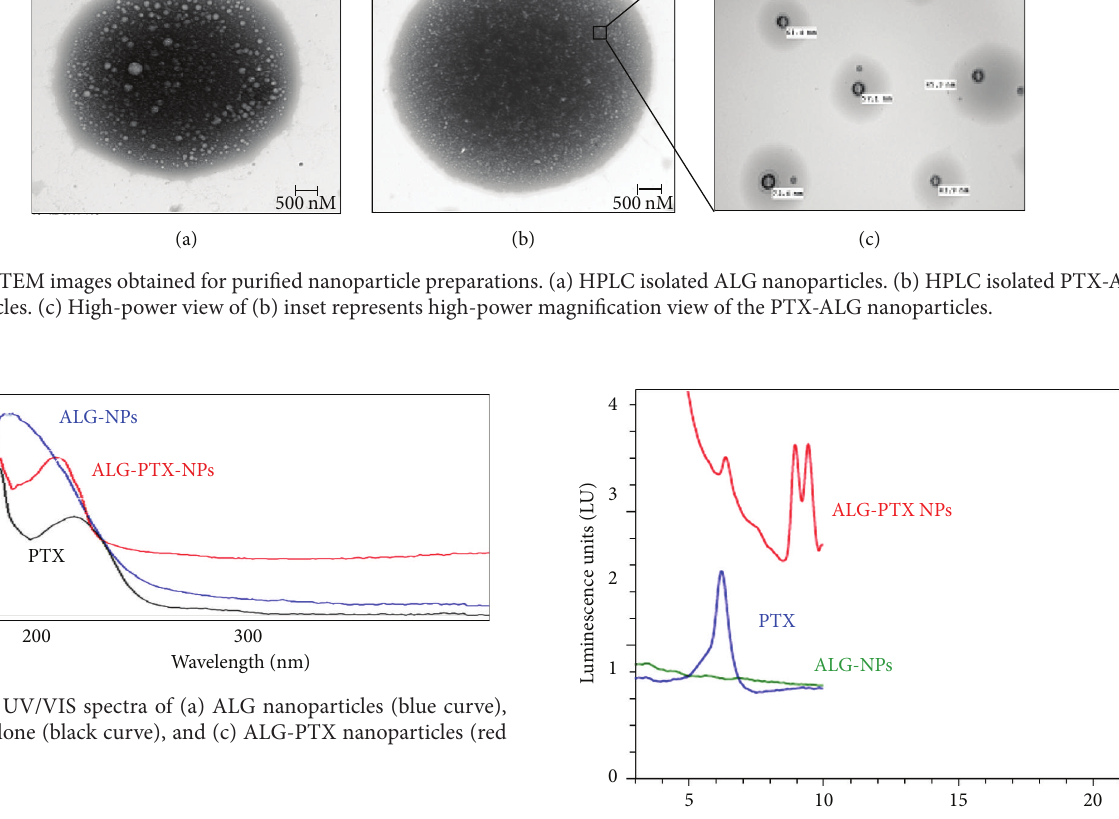
Figure 4: HPLC fluorescence for PTX alone (blue), ALG nanopar- ticles (green), and ALG-PTX nanoparticles (red). A Zorbax Extend C18 column ( 150 × 4.6 mm ID × 5 𝜇 m particle size) was used for nanoparticles isolation with a mobile phase 40% of water, 35% acetonitrile (ACN), and 25% methanol and a flow rate of 1.5 mLmin −1 . Excitation was 232 nm and emission at 353 nm. LU represents luminescence units